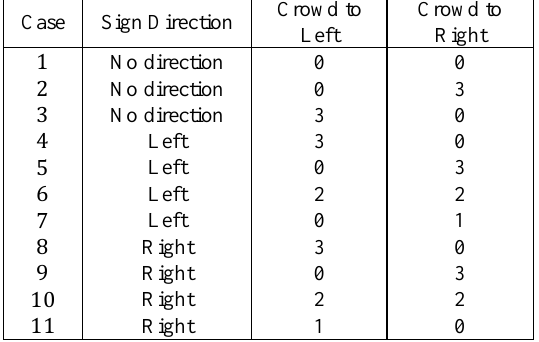
Table 2. Case setup for scenario 2